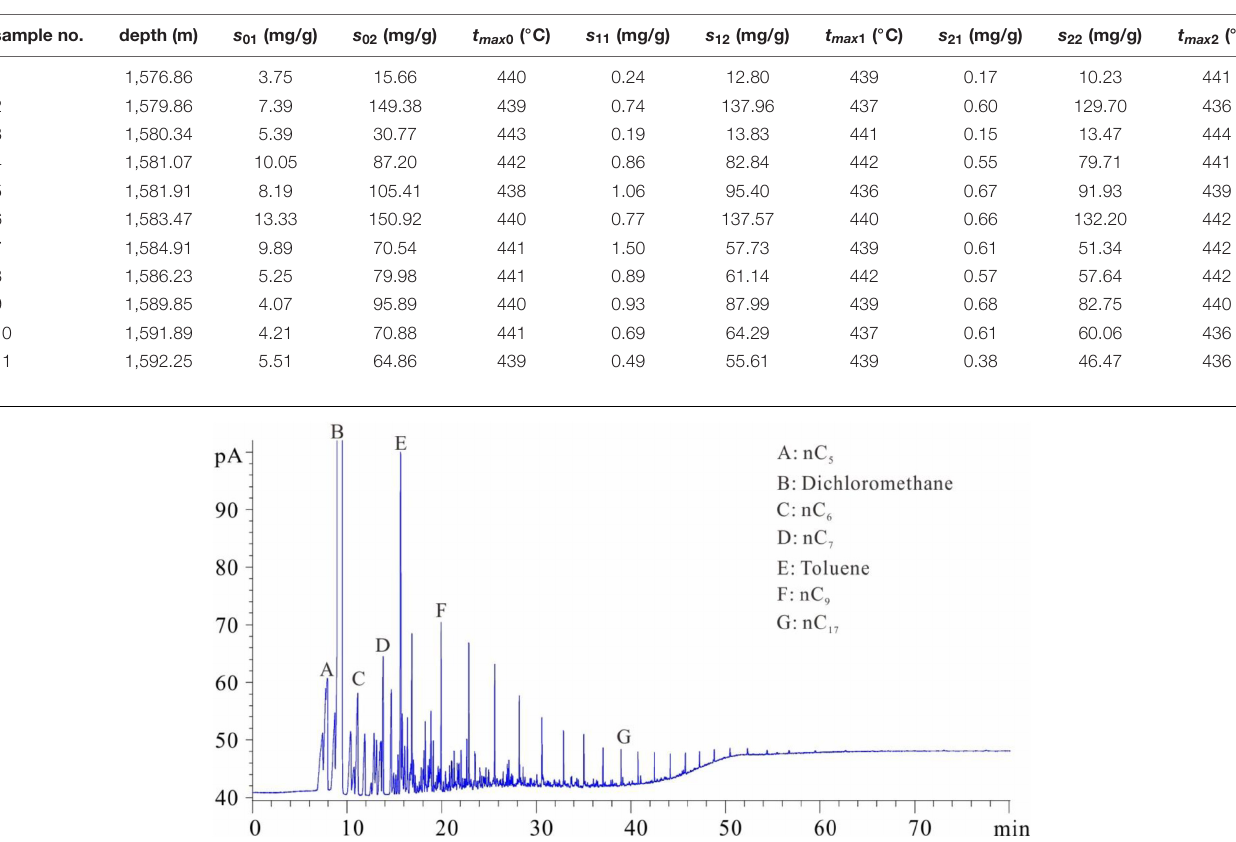
TOC, total organic carbon. TABLE 2 | Pyrolysis results of samples after various treatments. sample no.